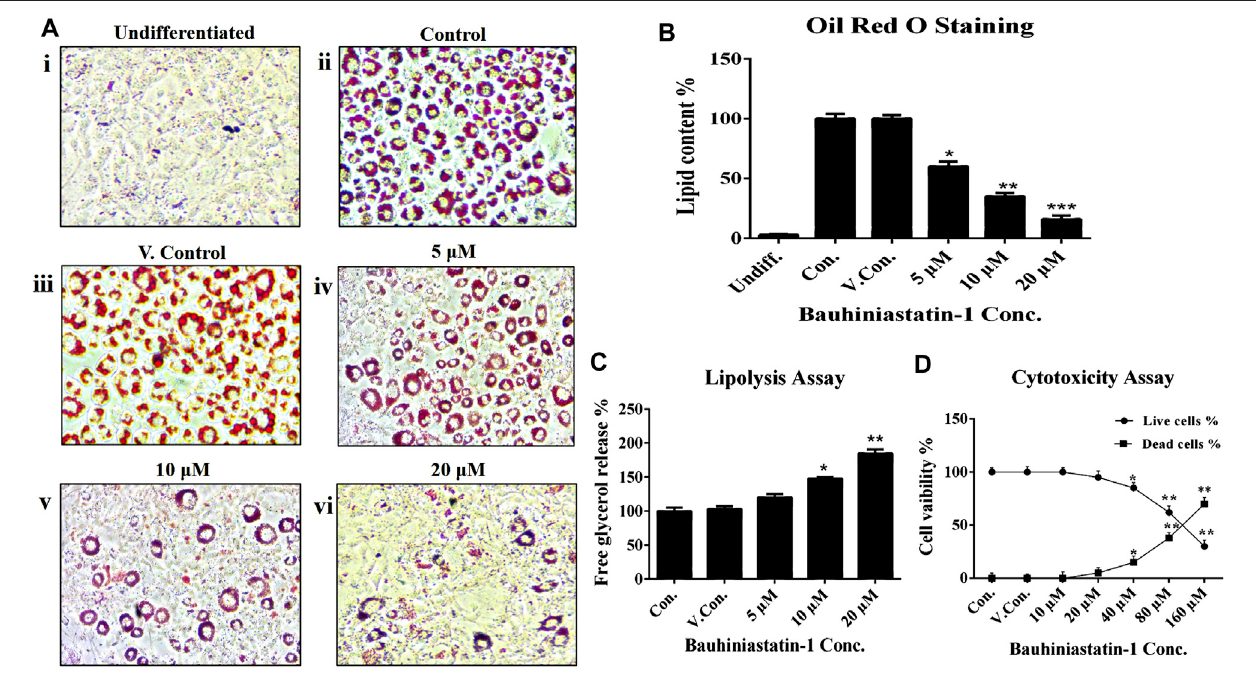
FIGURE2| EffectofBSTN1onlipidlevelsin3T3-L1cellsby (A) OilRedOstainingof3T3-L1cells(Magni fi cation40 × ).(i)Undifferentiated,untreatedpre-adipocytes (ii) Differentiated, untreated adipocytes (control) (iii) DMSO (0.01%) treated adipocytes (vehicle control). (iv), (v), and (vi) BSTN1 treated adipocytes (5, 10, and 20 μ M) showingdecreasedadipogenesisindosedependentmanner. (B) Quanti fi cationoflipidcontent(%)byOilRedOstainextractioninBSTN1-treatedandothergroups. (C) Lipolysis assay indicating the amount of glycerol content released from 3T3-L1 adipocytes into the media. (D) Cytotoxicity assay results on the percentage of cell viability of untreated, DMSO and BSTN1 treated pre-adipocytes determined after 48 h using MTT assay. Data are presented as mean ± SD of triplicate. *, **, and *** indicate signi fi cant difference between control and treated 3T3-L1 cells at p < 0.05, p < 0.01, and p < 0.001 respectively.